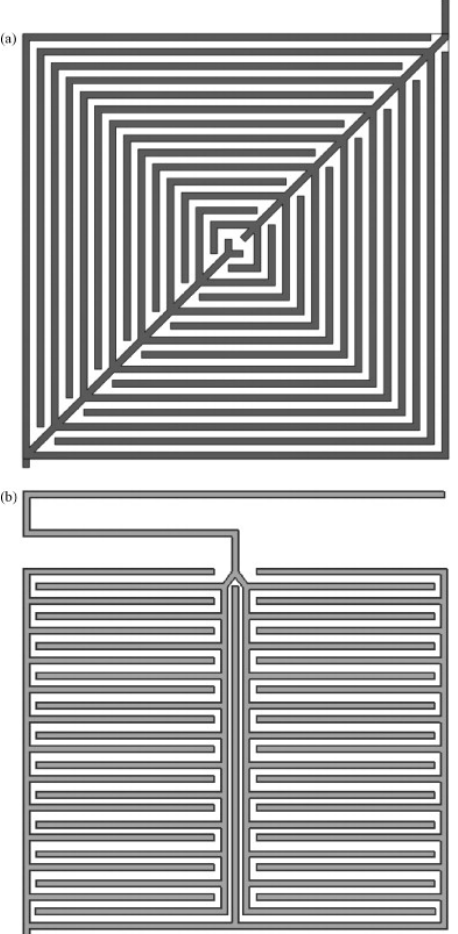
Figure 14. The novel ( a ) leaf and ( b ) lung flow field